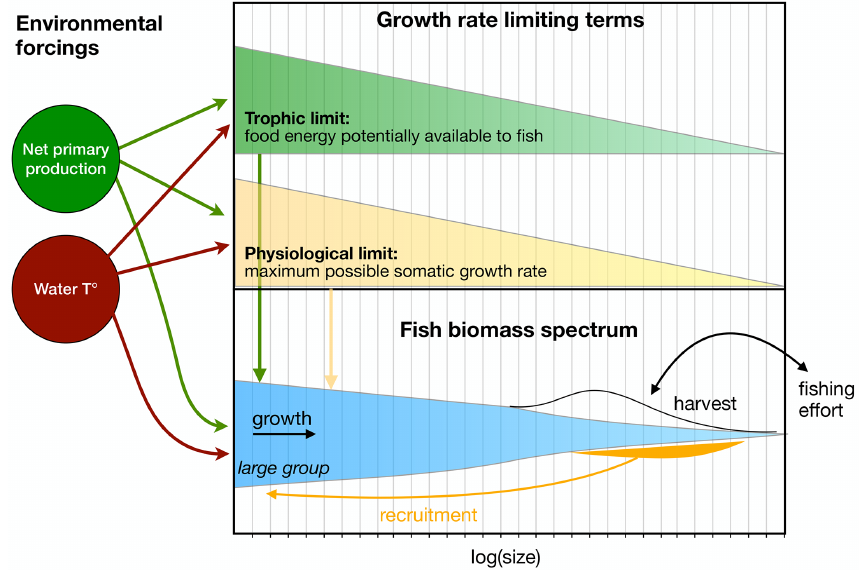
Figure 2. Schematic overview of the BOATS model. The red, green, and black arrows indicate dependencies of model components on external forcings. The top panel indicates the energetic limits of growth as a function of fish size, while the bottom panel illustrates the three size spectra of fish groups (for simplicity only the large group is represented), their internal dynamics, and the link to economics via harvest and the interactive